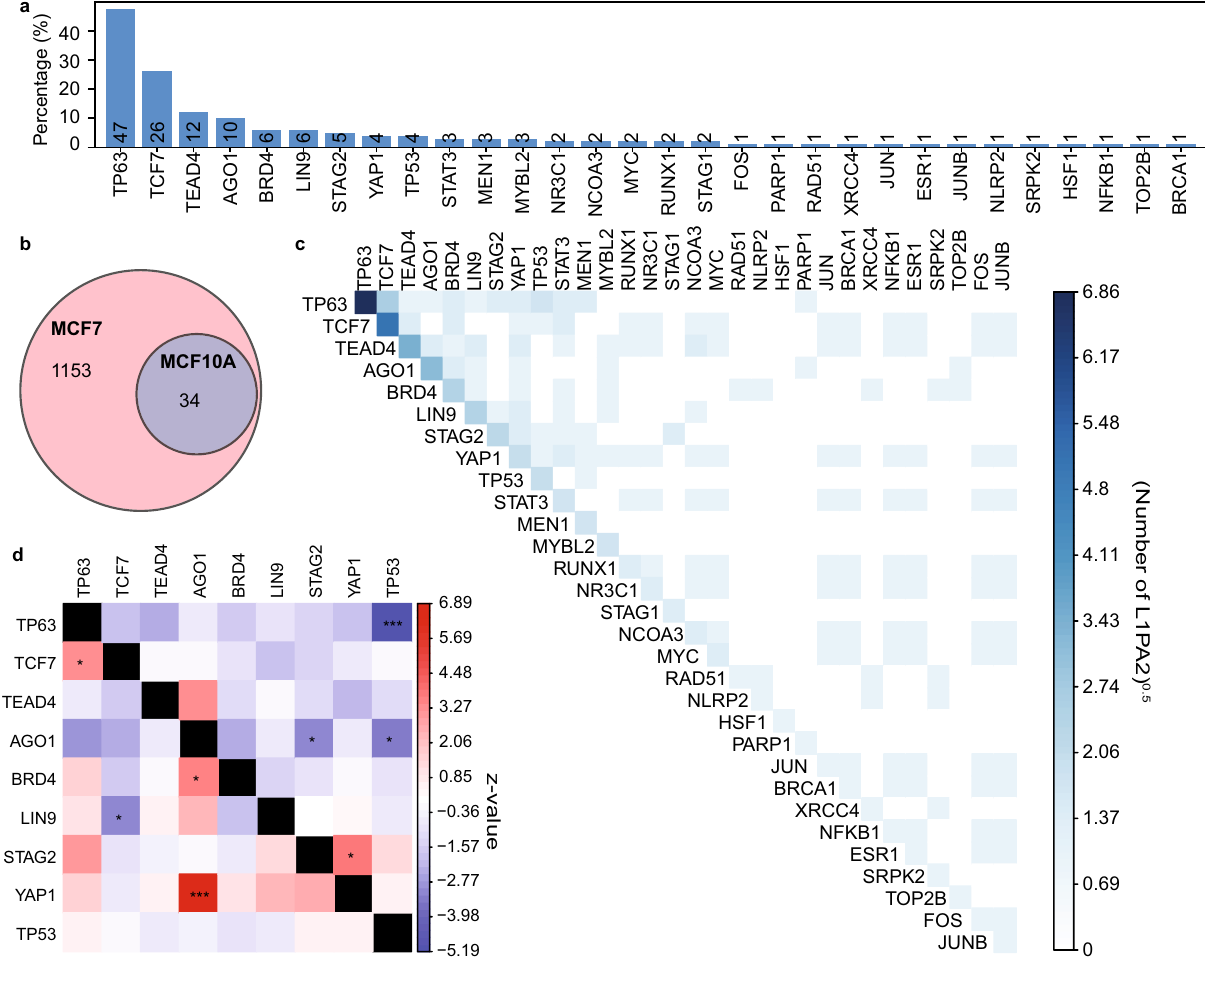
Figure 5. L1PA2 transposons showed fewer occurrences of TF binding and binding site co-localisation in MCF10A near-normal cells. ( a ) A total of 30 TFs were found to bind L1PA2 transposons in MCF10A cells. The bars and numbers show the percentages and counts of TF-bound L1PA2 transposons (n = 99) respectively. ( b ) The venn diagram shows the overlaps between L1PA2 transposons that harbour TFBSs in MCF7 and MCF10A cells, considering only TFs that were studied in both cell lines (not drawn to scale). ( c ) TFBS co-localisation for frequently binding TFs in MCF10A cells. For each pair of TFs, the number of L1PA2 transposons containing both TFBSs in MCF10A cells is shown in the heatmap, where the counts are transformed (n 0.25 ). ( d ) Co-localisation enrichment analysis was performed for the most frequently binding TFs. For each TF-TF combination, the co-localisation proportions were compared (L1PA2 versus non-L1PA2) using a one-tailed proportion z-test. The heatmap indicates the z-scores of the proportion tests, where a positive z-score (red) indicates more co-localisation in L1PA2s, and a negative z-score (blue) indicates more co-localisation in the rest of the genome. P < 6.2E−4: *, p < 0.0001: **, p < 0.00001: ***. To account for asymmetrical co-localisation, the proportions and z-scores correspond to the chances of the TF in the row co-localising with the TF in the